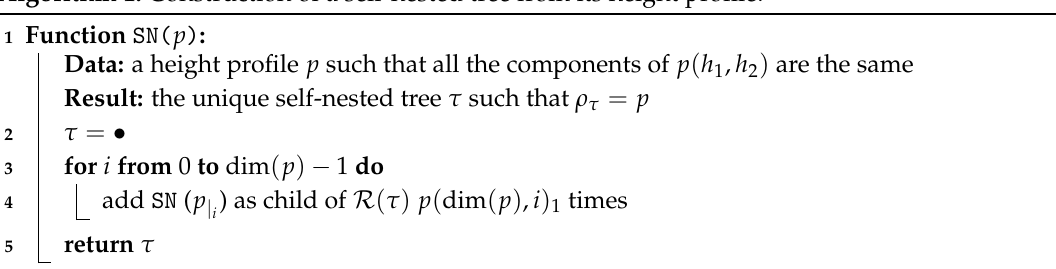
Algorithm 1: Construction of a self-nested tree from its height